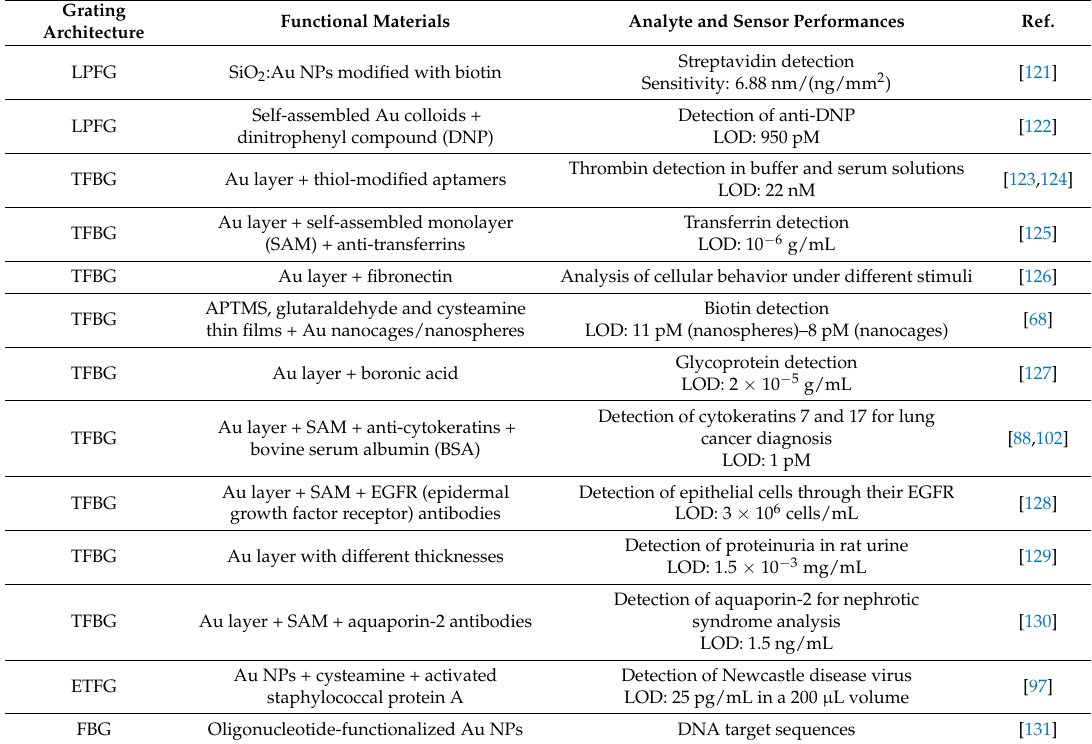
Table 1. Summary of the main characteristics of different plasmonic fiber-grating immunosensors reported so